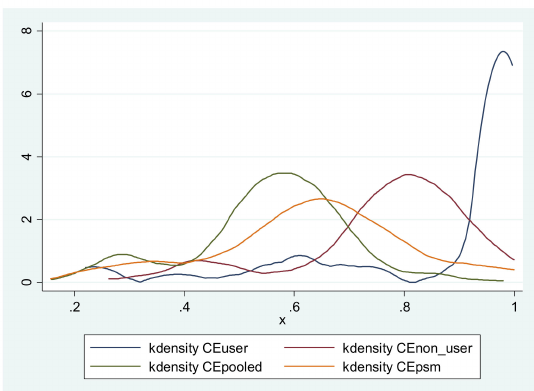
Figure 1. Kernel density distribution for the cost e ffi ciency distribution. Notes: CEuser, CEnon_user, CEpooled and CEpsm represent cost e ffi ciency distribution for users, non-users, pooled unmatched sample and for the pooled matched sample